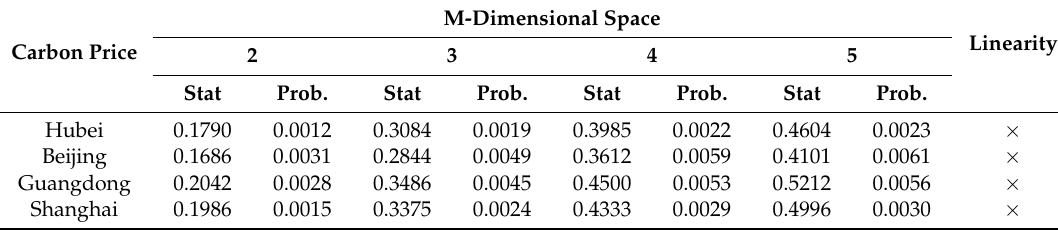
Table 4. BDS test